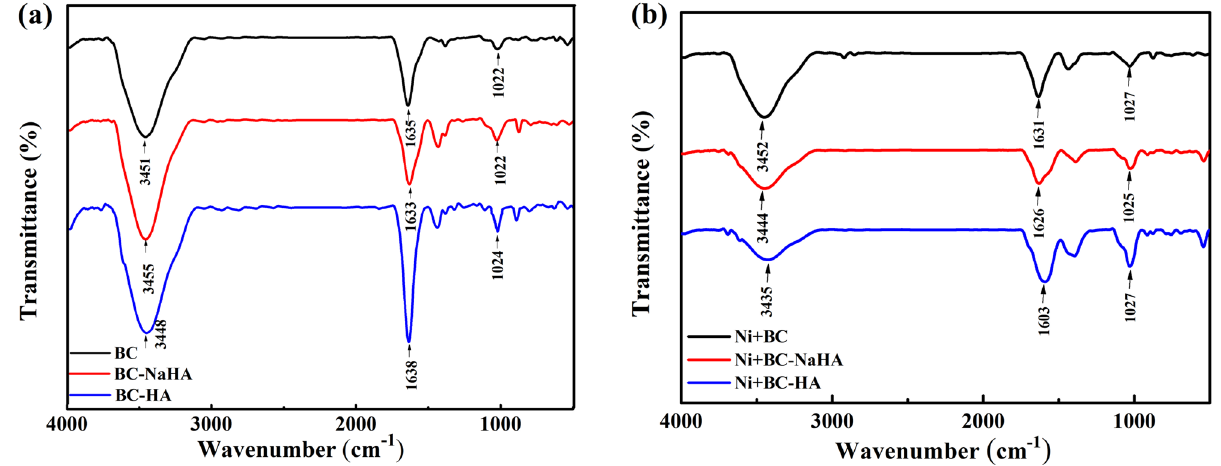
Figure 5. FT-IR spectra of ( a ) BC, BC-NaHA, and BC-HA; ( b ) Ni(II) ions immobilized by BC, BC-NaHA, and